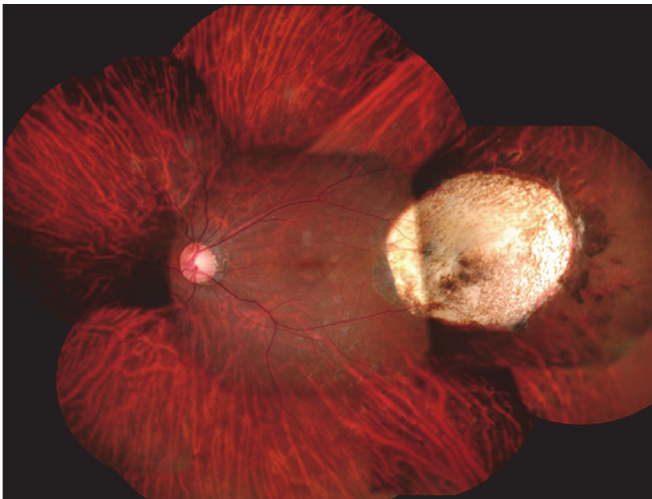
Figure 3: A fundus examination 10 months after the primary operation revealed bare sclera at the temporal side of the macula where the tumor was